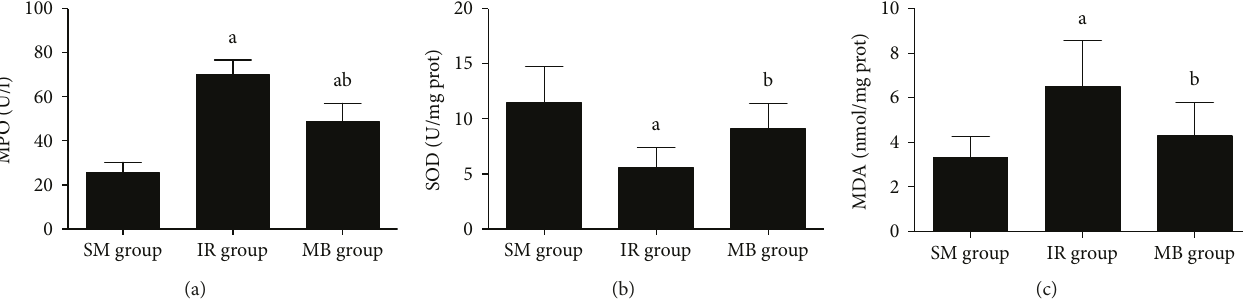
Figure 4: MPO and SOD activities and MDA level in lung tissue. (a) MPO activity in lung tissue; (b) SOD activity in lung tissue; (c) MDA level in lung tissue. a p < 0 05 versus SM group; b p < 0 05 versus IR